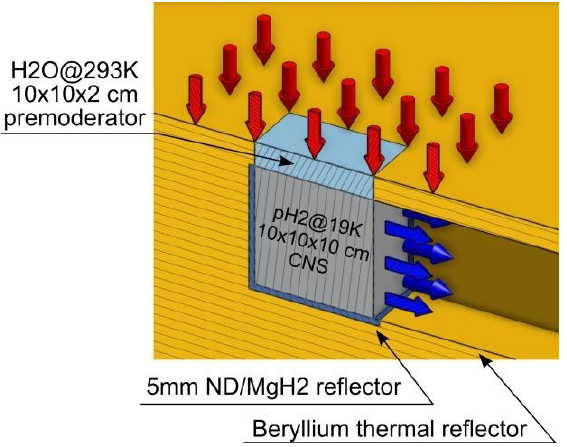
Fig.12 : Geometry used to test the efficiency of nanodiamods and cold magnesium hydride as